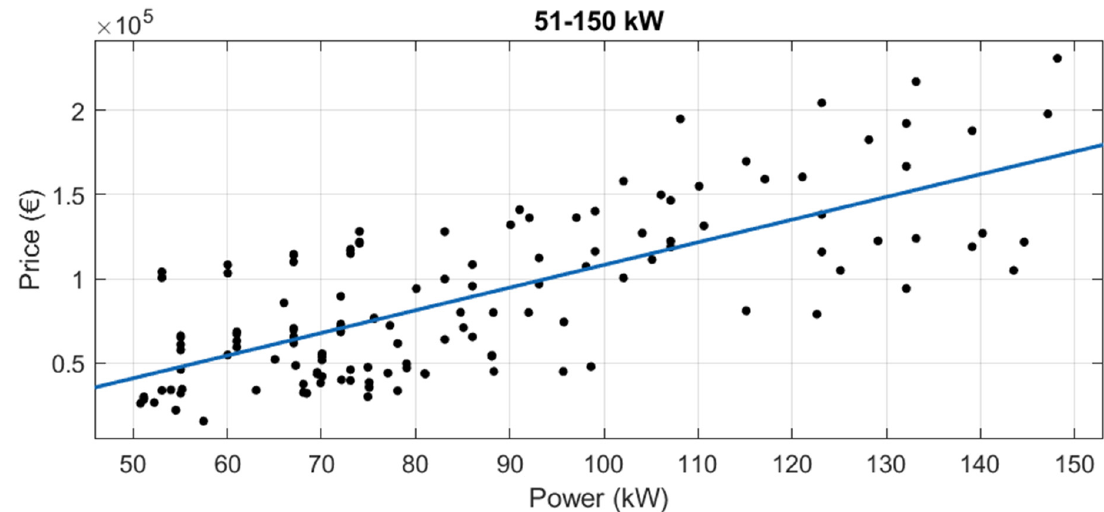
Figure 13. Price vs. power for new tractors from 51 to 150 kW.